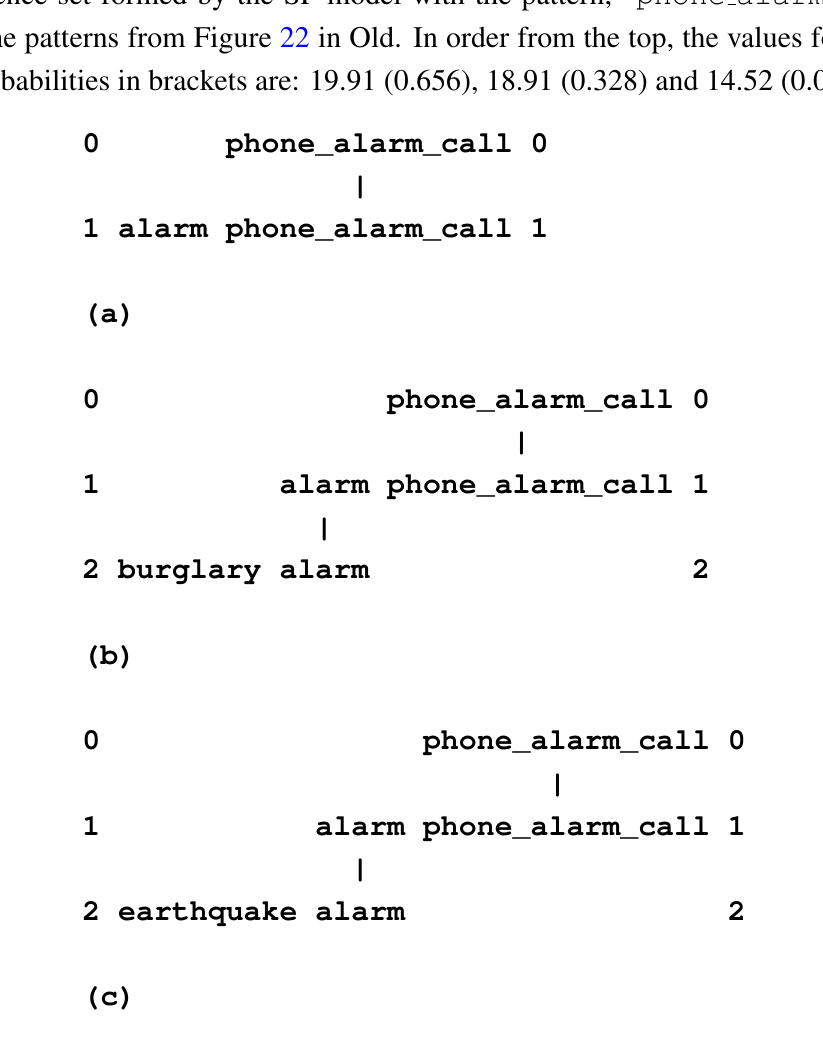
Table 1. The probabilities of unmatched Old symbols, calculated by the SP model for the three multiple alignments shown in Figure